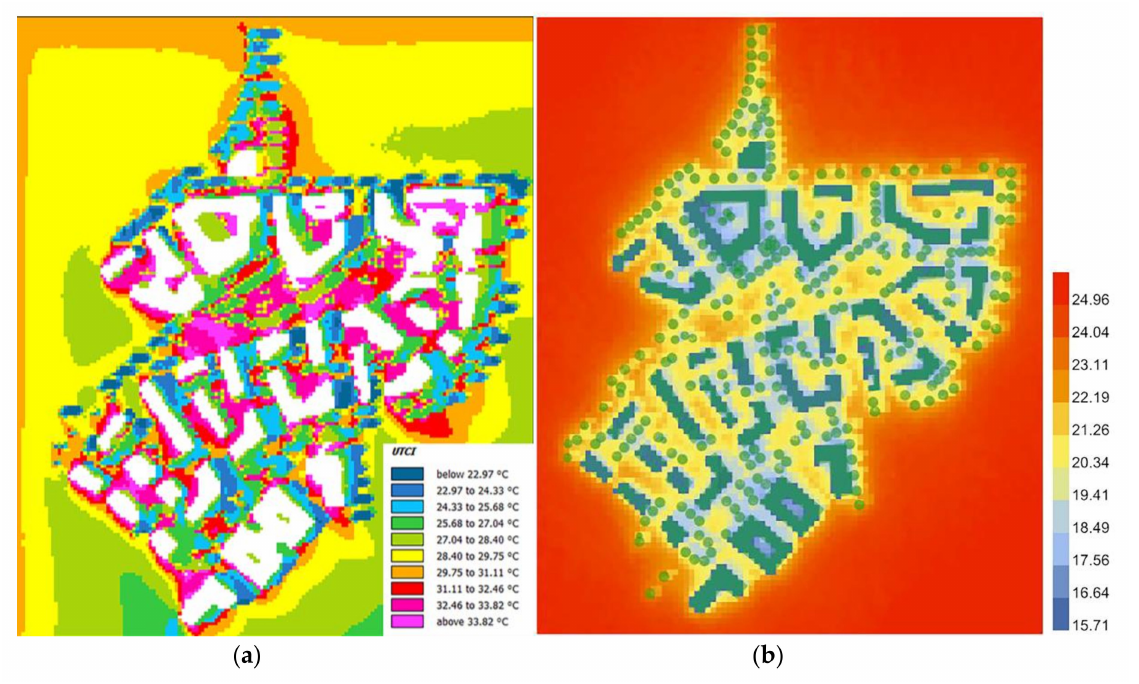
Figure 5. Comparison of UTCI simulations: ( a ) ENVI-met; ( b ) Ladybug (source: